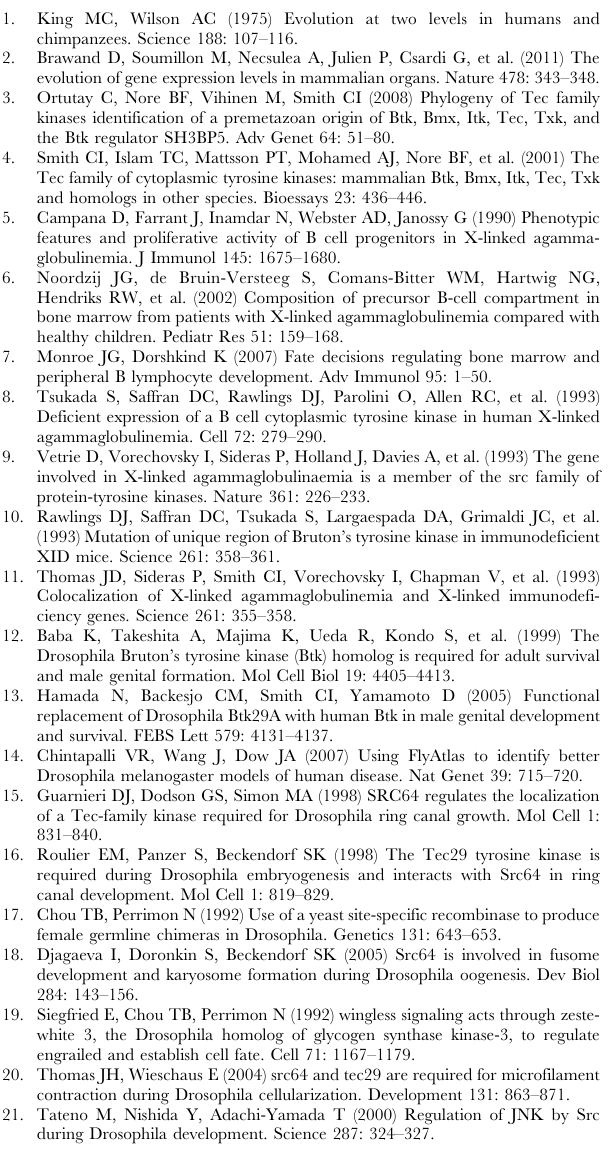
Table S1 Table S1 mirrors Table 1 ( 25 genes found to overlap between D. melanogaster larvae CNS and adult head ) in addition of adding the dimension of every gene’s Gene Ontology term including Gene Ontology